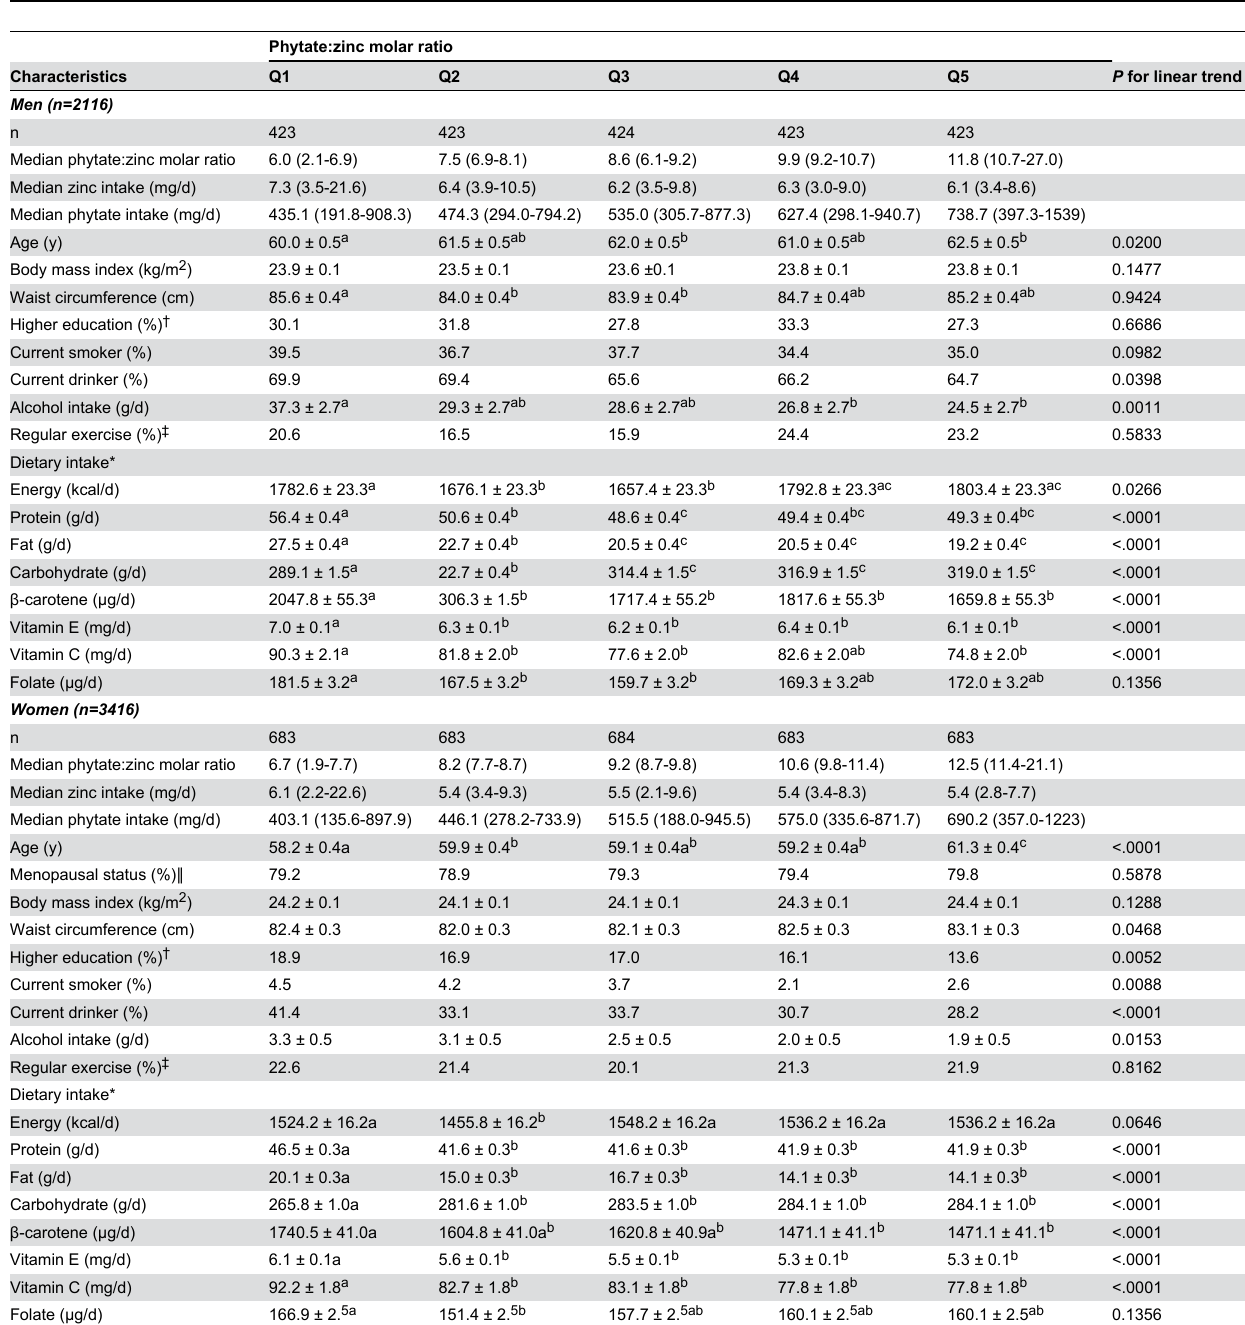
Table 2. Age-adjusted characteristics of the study population according to phytate:zinc molar ratio